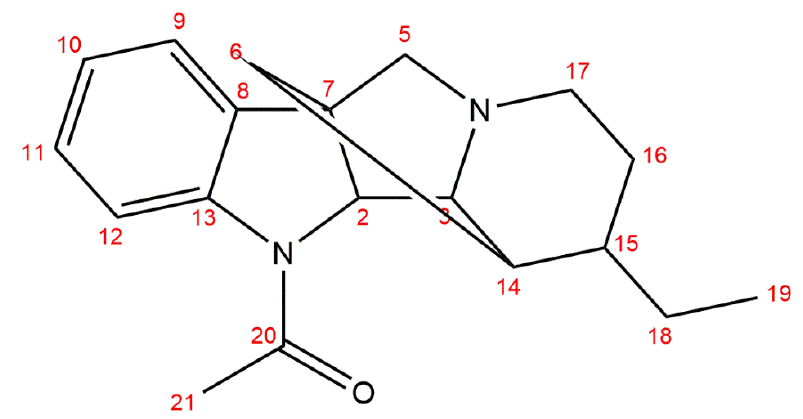
Figure 1. Chemical structure of geissospermiculatine.